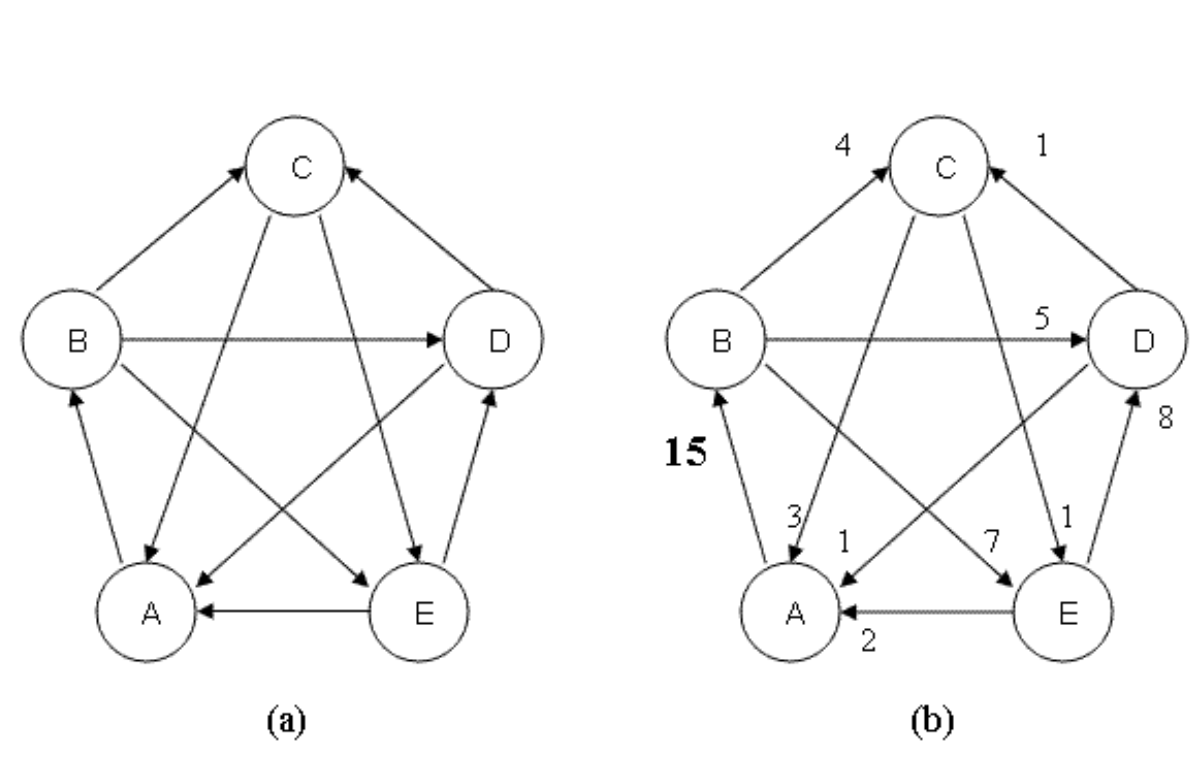
Figure 1: Pairwise dependencies: without (a) and with (b) the level of preference graph on the right hand-side of Figure 1 these values are represented as weights of directed edges.